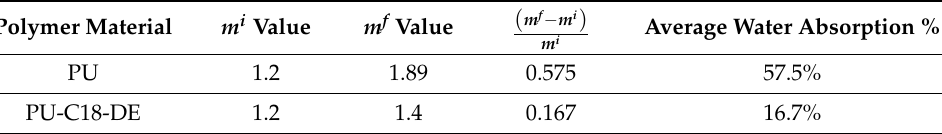
Table 4. Calculation of water absorption percentage to understand hydrophobicity of the unmodified and modified PU